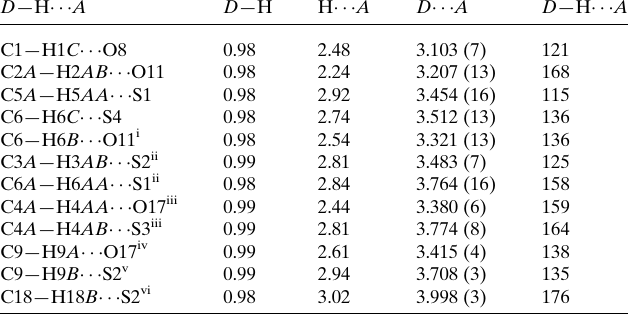
Table 2 Hydrogen-bond geometry (A˚ , (cid:4) ).